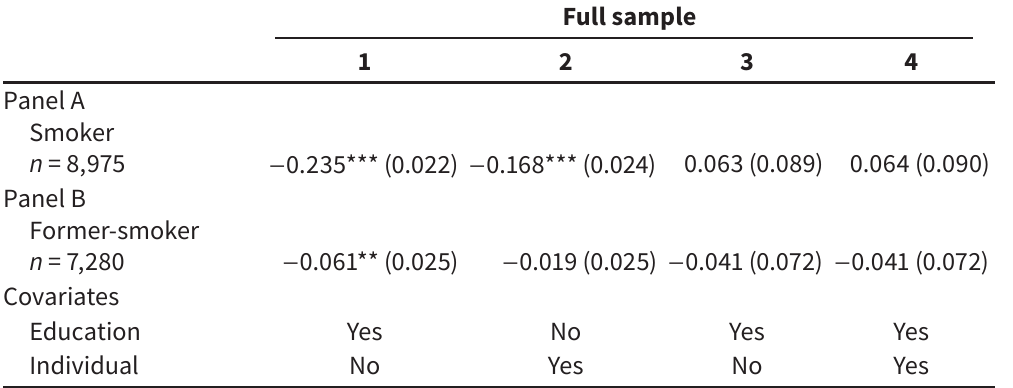
The earnings impact of smoking for the full sample Full sample 1